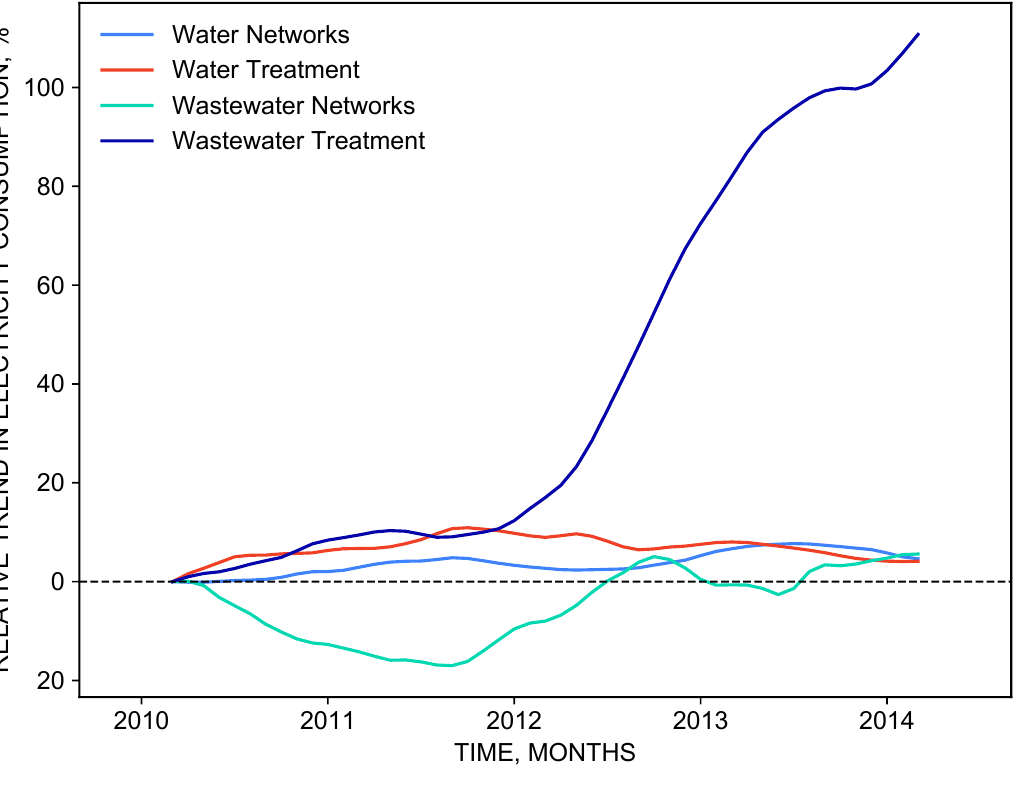
Figure 4. Derived trend components ( α ) for each functional category: water networks, water treatment, wastewater networks and wastewater treatment. Shown as relative change (%) using the first term in the time series as the base